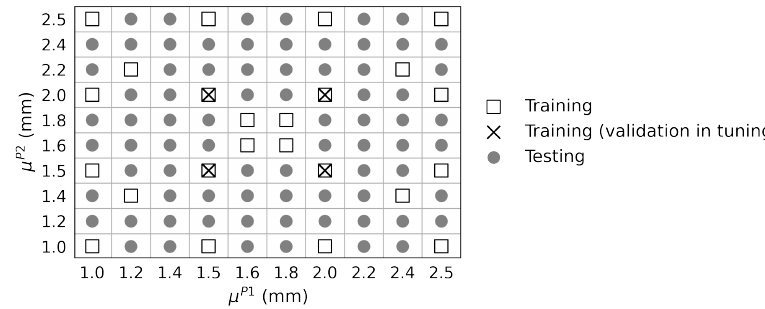
Figure 10. Sample distribution in parametric space of training and testing sets for model H 2 .